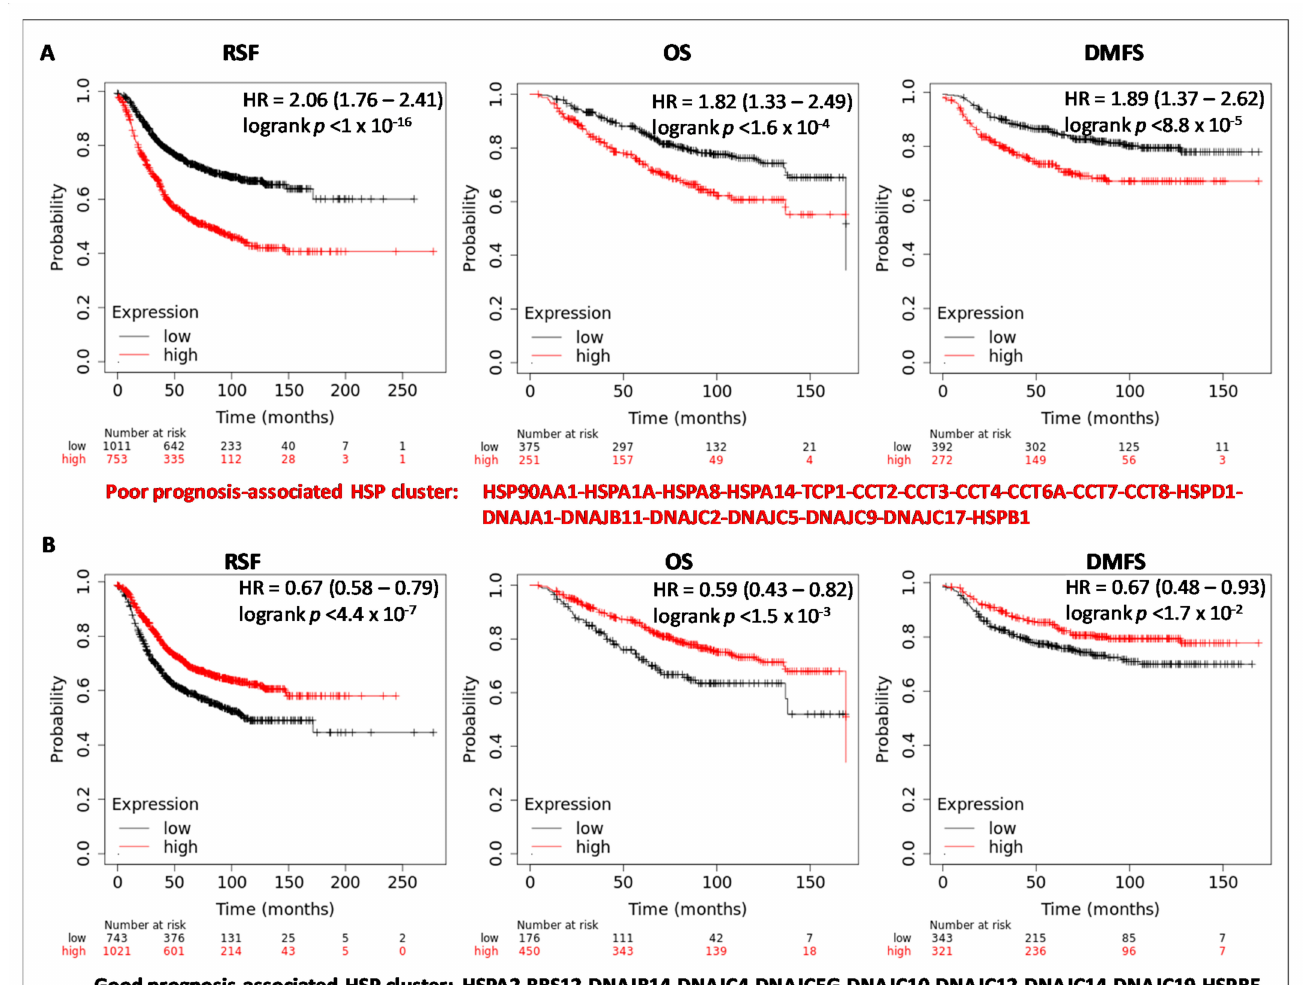
Figure 4. Survival curves of HSP members significantly associated with prognosis. The analysis is shown for Relapse Free Survival (RFS) Overall Survival (OS) and Distant Metastasis Free Survival (DMFS) using the Kaplan-Meier Plotter database. Patients were divided into two groups by using the best cut-off of probe expression. Survival curves of HSP-cluster associated with poor ( A ) and good ( B )